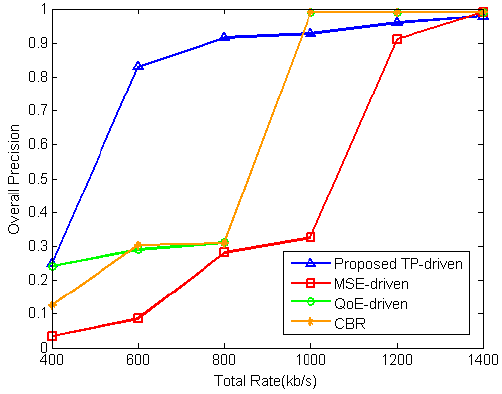
Figure 12. Product of tracking precision of each video under different total rate constraints. The packet loss rate of each video is 1%.